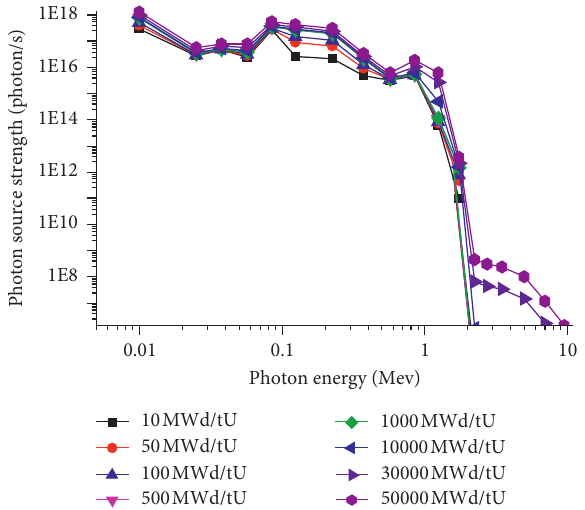
Figure 2: The photon source strength under different fuel consumption.